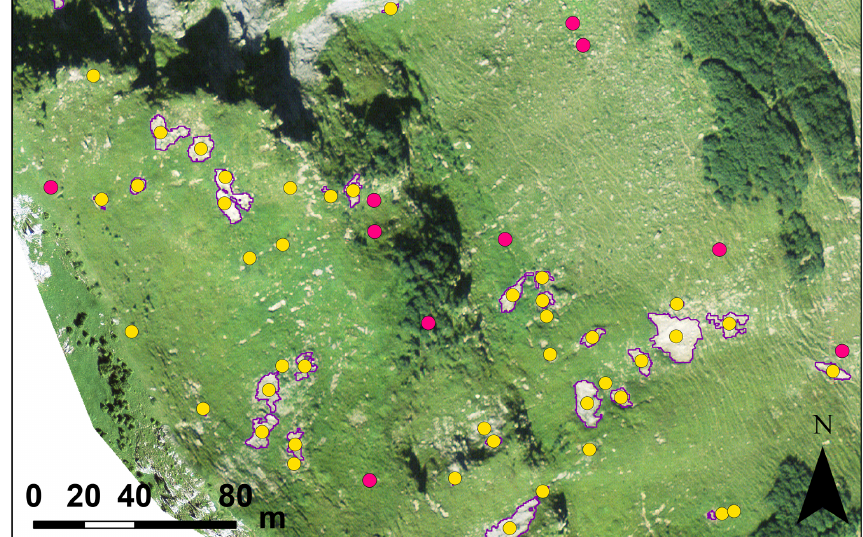
Figure 4. Example of mapped shallow landslides in the Turbach valley (purple). The centred points (yellow) represent shallow-landslide lo- cations for the lasso model evaluation. Only sites with an area larger than 4m 2 were used for the evaluation. Red points represent randomised non-landslide points. Aerial image (2013) obtained from ©